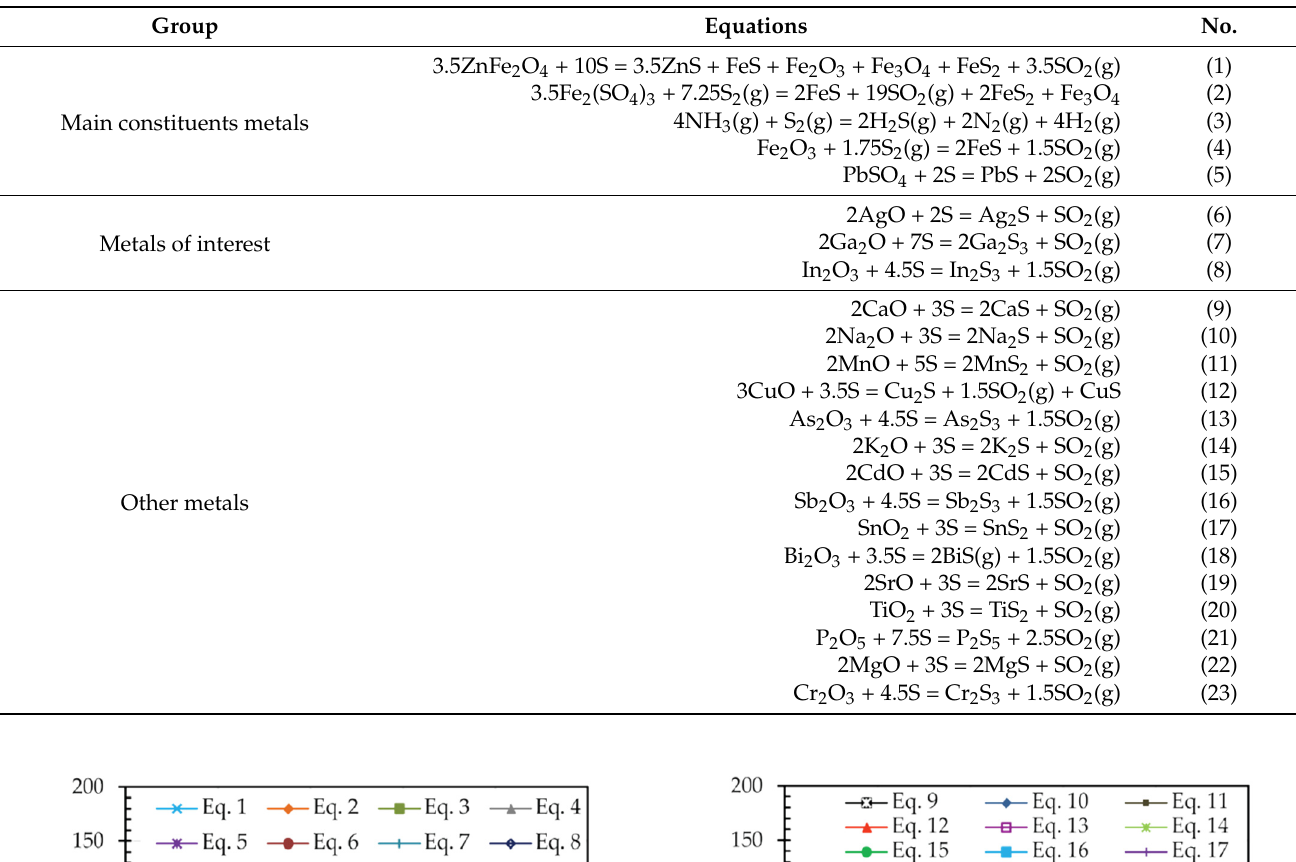
Table 4. Reactions of jarosite-PbAg sludge with sulfur.